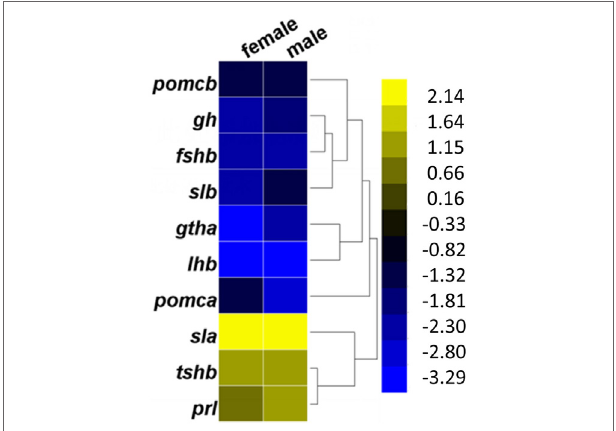
FigUre 2 | Changed expression pattern of genes in GH-transgenic (T) common carp compared with non-transgenic (NT) common carp. Fold change of pituitary hormone-encoded genes in female and male T common carp compared with NT animals. Yellow represented for upregulation, dark blue and dark yellow for nearly no expression change, and blue for